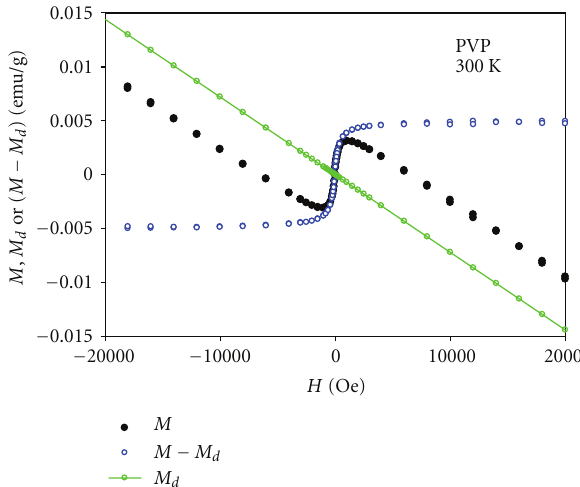
Figure 5: Magnetization M of PVP can be resolved into two com- ponents. The expected diamagnetic M d is linearly proportional to H with a negative slope. The di ff erence ( M − M d ), reaching saturation below 1,000 Oe, likely arises from minor magnetic